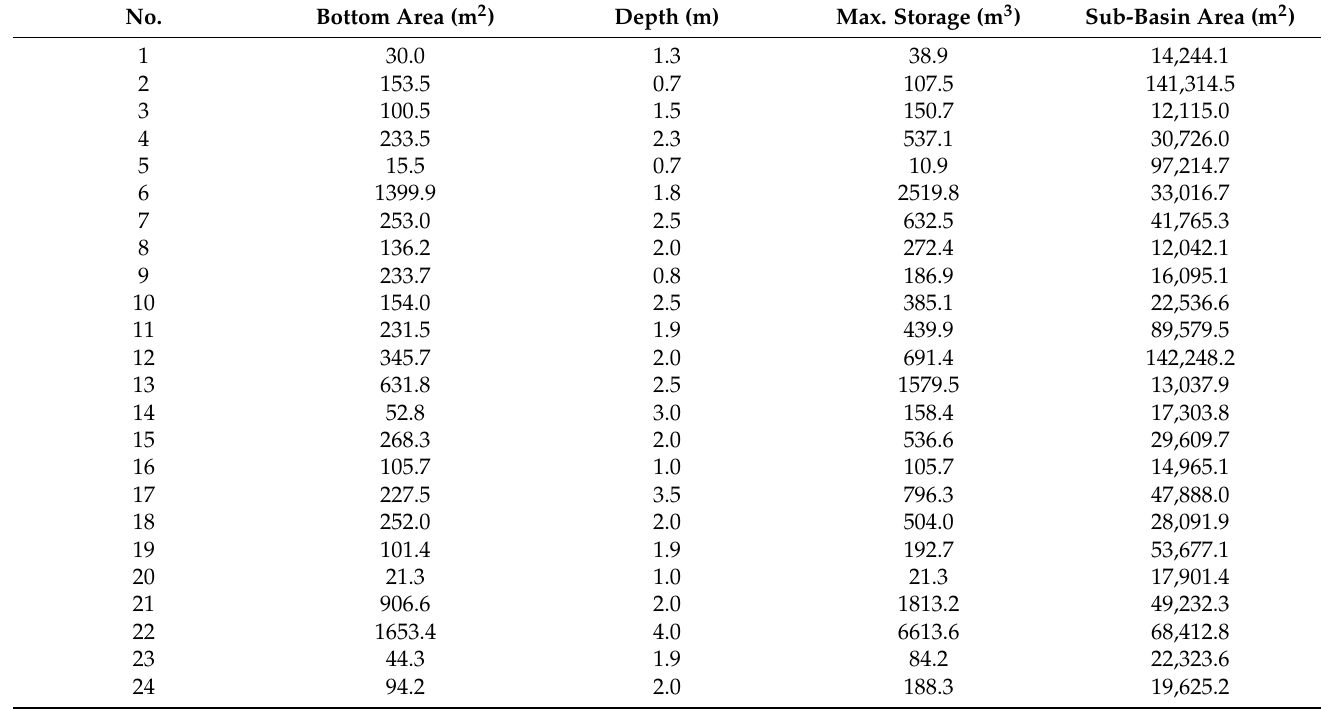
Table 3. Basic characteristics of the mool-tongs considered in this